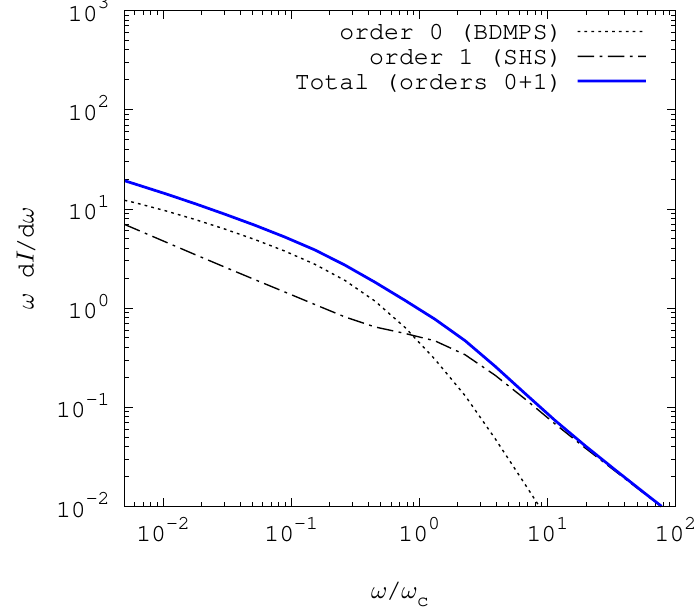
Figure 4 . The medium-induced spectrum to NLO in the expansion around the harmonic oscillator. The leading order (order 0) corresponds to the BDMPS spectrum (dotted) and the (cid:12)rst correction (order 1) accounts for to single hard scattering regime (dotted-dashed). The total spectrum is represented by a blue solid line. Numerical values of the parameters are the same as in (cid:12)gure